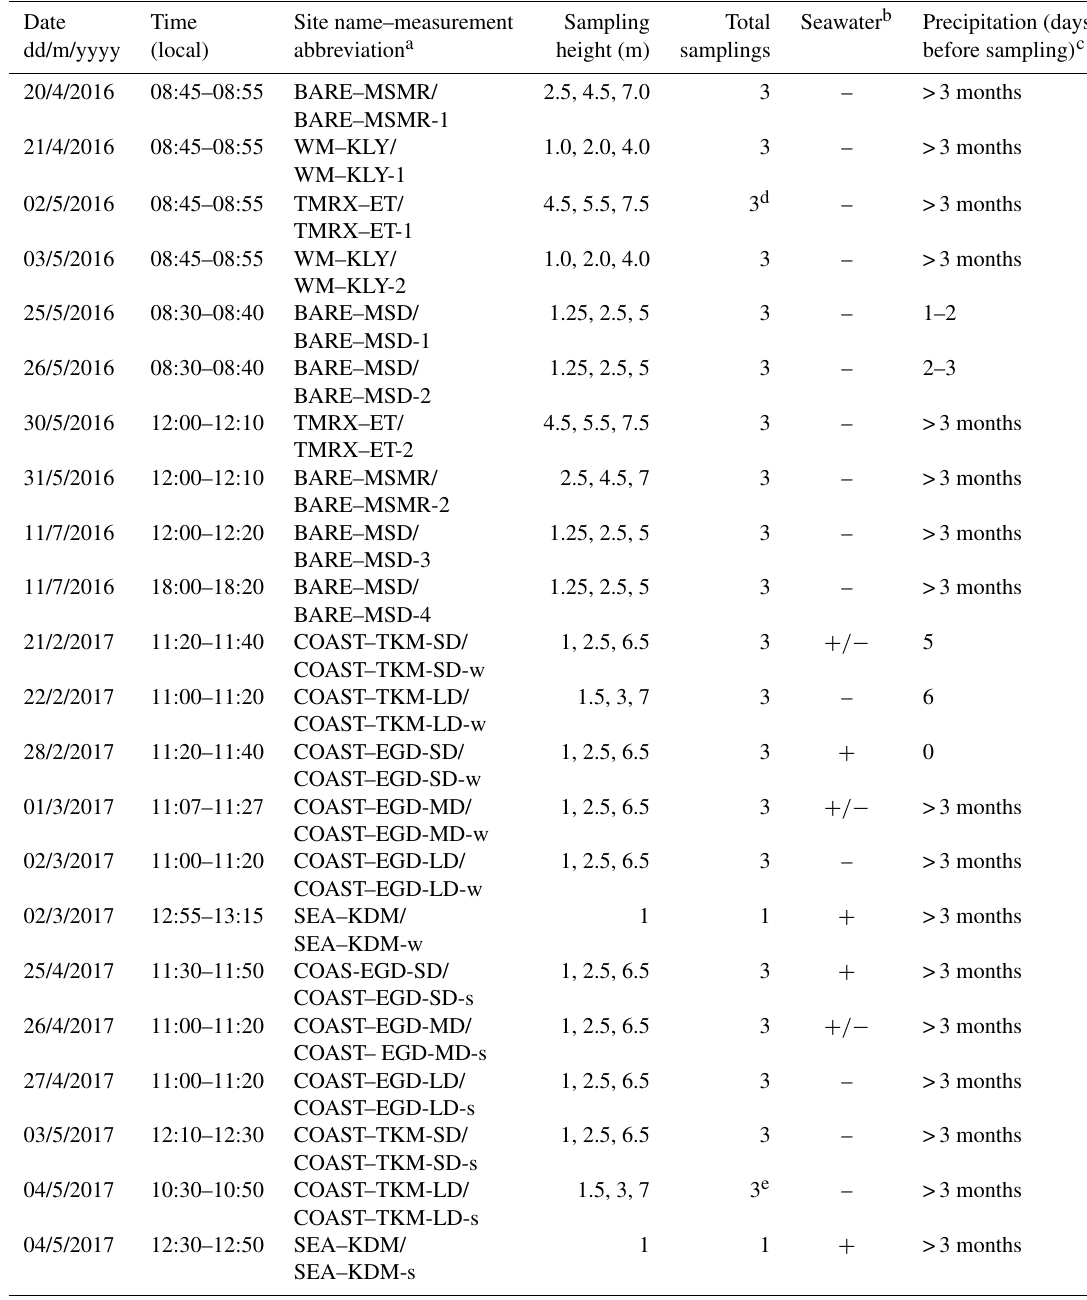
Table 1. Summary of VHOC samplings at the Dead Sea. Shown are the date, time and site name (and abbreviation) for the sample, sampling height, total number of samplings for each experiment and whether the sample could potentially have been influenced by emission from the seawater and by precipitation prior to